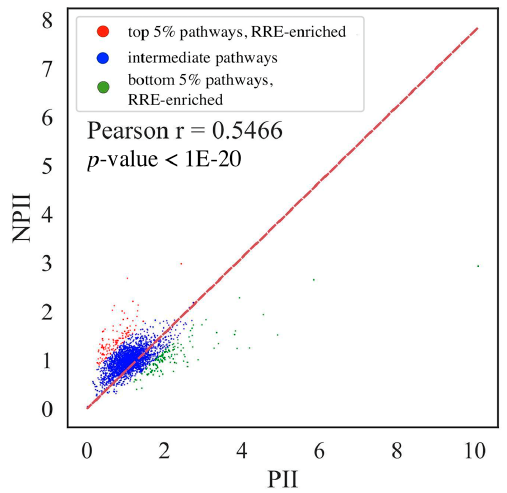
Figure4. ComparisonofPIIscores(abscissaaxis)andNPIIscores(axisofordinates)forhumanmolecular Figure 4. Comparison of PII scores (abscissa axis) and NPII scores (axis of ordinates) for human molecular pathways. Color indicates different pathway groups (red—RRE-enriched molecular pathways. Color indicates di ff erent pathway groups (red—RRE-enriched molecular pathways, pathways, blue—intermediate pathways, green—RRE-deficient molecular pathways). Each dot blue—intermediate pathways, green—RRE-deficient molecular pathways). Each dot represents represents single pathway. Pearson correlation coefficient (r) and Pearson p -value ( p ) are shown single pathway. Pearson correlation coe ffi cient (r) and Pearson p -value ( p ) are shown separately.